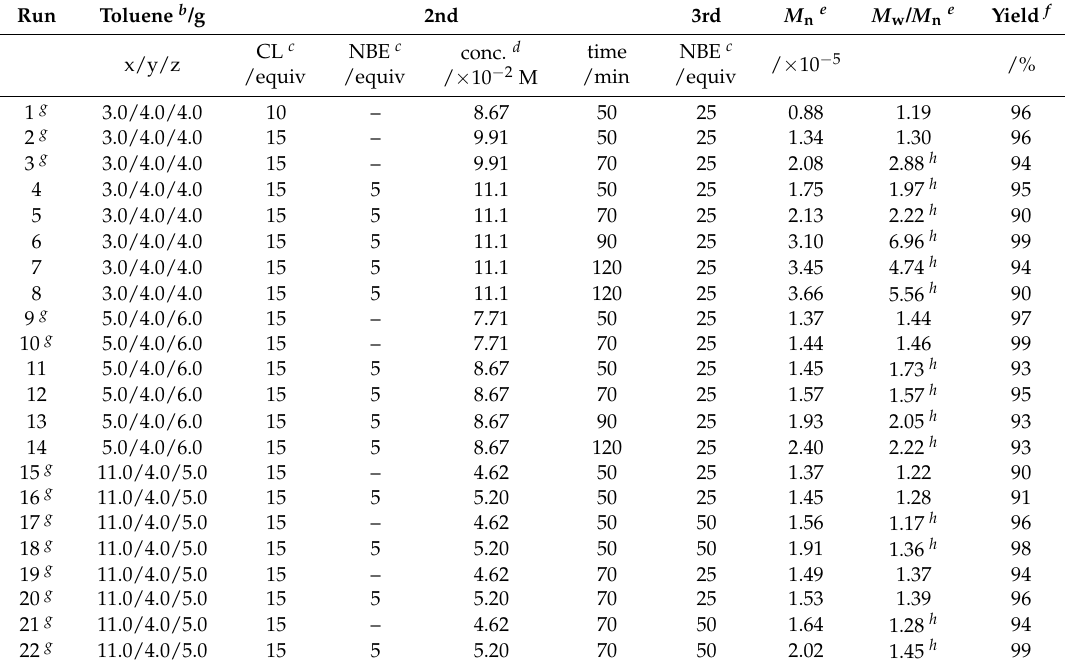
Table 1. Synthesis of star-shaped polymers by living ring-opening metathesis polymerization